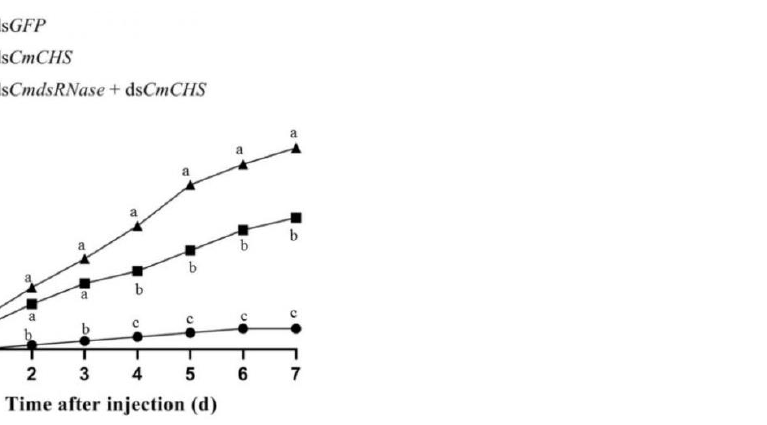
Figure 10. Corrected mortality of larvae within seven days after dsRNA injection. Corrected mortality of the third-instar C. medinalis larvae was calculated within seven days after injection with ds CmCHS or the mixture of ds CmdsRNase and ds CmCHS. Larvae injected with ds GFP were used as the control group. Different letters above the broken lines indicate significant differences between treatments on the same day ( p < 0.05, Duncan’s test).